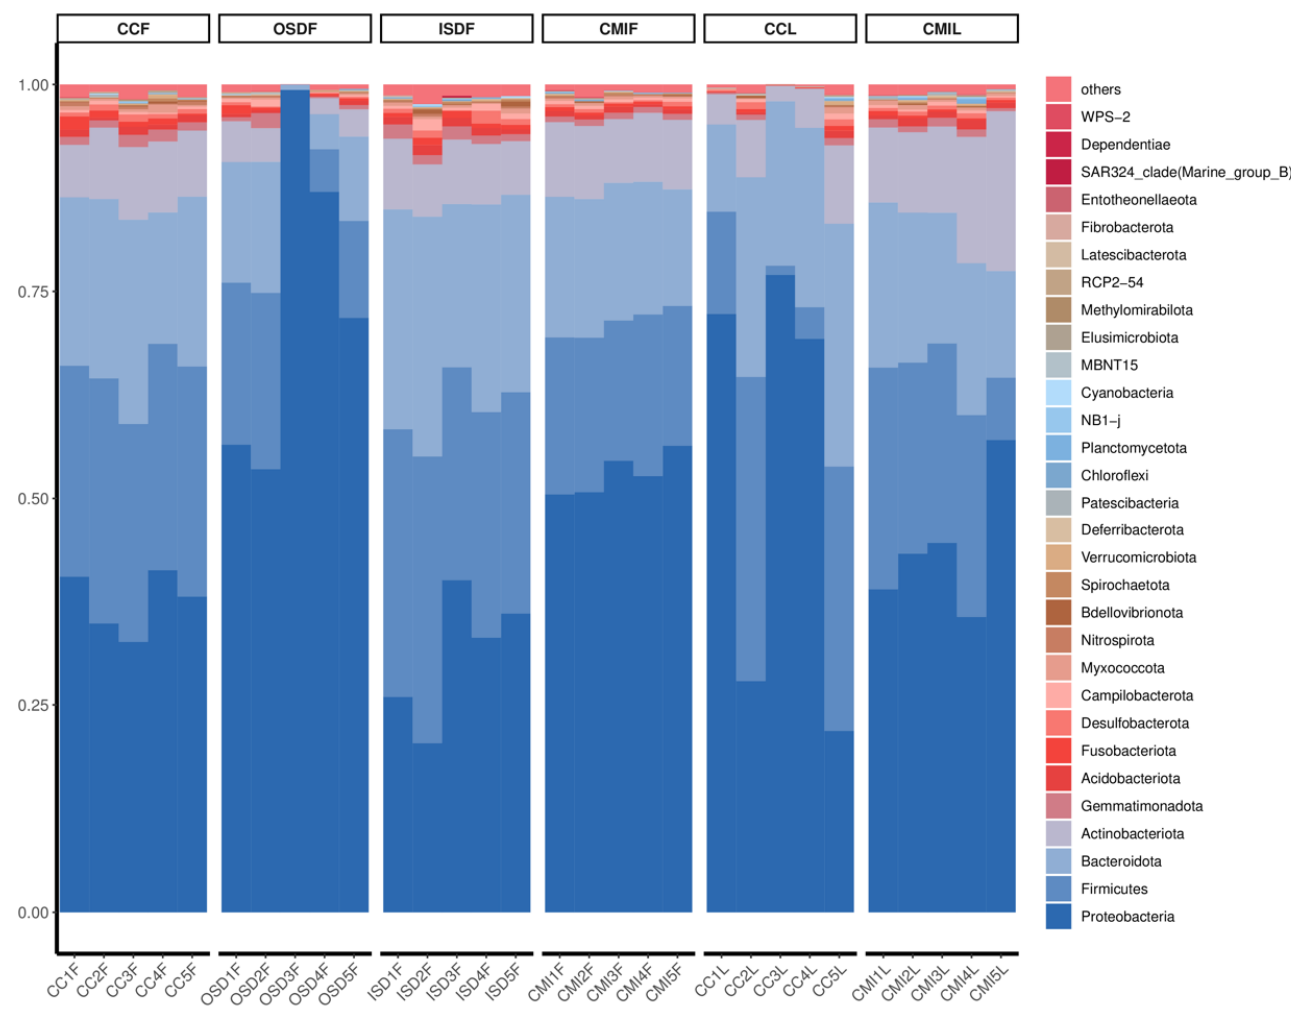
Figure 3. Relative abundances of potential top 30 pathogens at the phylum level in grouped H. flava and H. longicornis samples. The groups of H. flava are CCF, OSDF, ISDF and CMIF, and the groups of H. longicornis are CCL and CMIL.